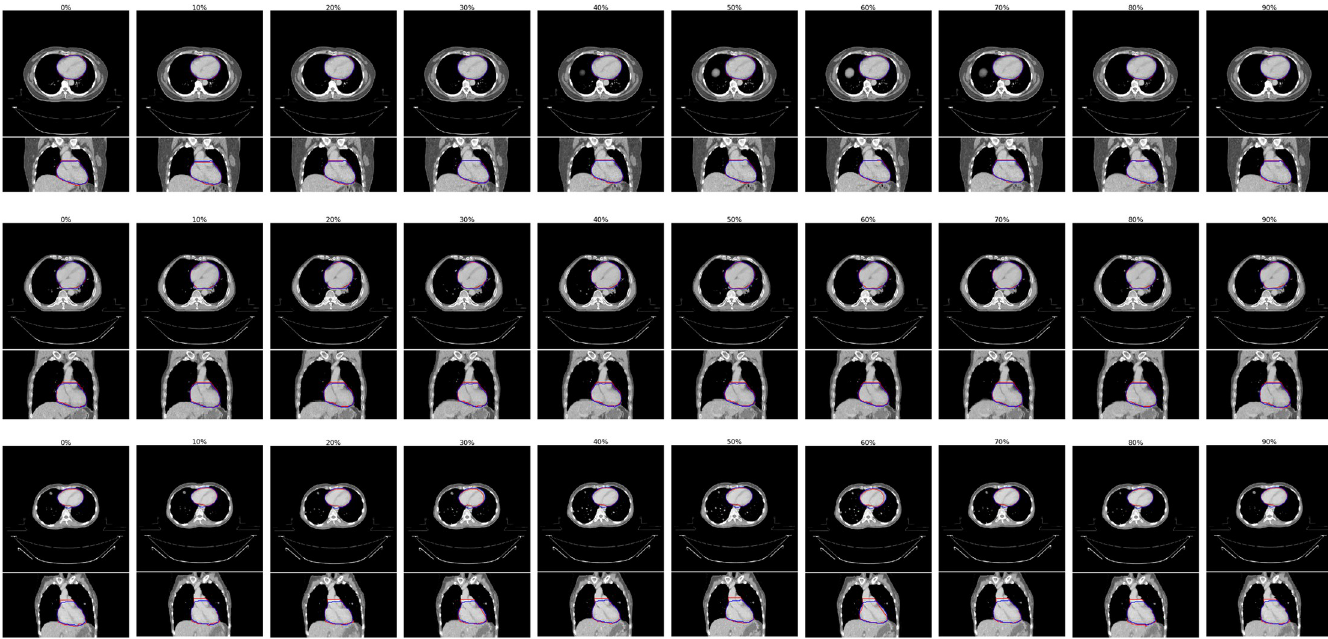
Fig 5. Examples of results from our proposed automatic heart segmentation method (blue), compared to manual contouring (red), shown here for the best (top), median (middle) and worst (bottom) performing patient image sets, as ranked using the mean absolute surface-to-surface distance (MASD). We display each binned respiratory phase image, 0% - 90% in 10% increments going left to right. Overall, our method provides consistently accurate delineations. Some variations from manual contouring can be seen, for example in the 60% in the bottom row, where deviations in manual contouring can be seen on the borders of the heart.